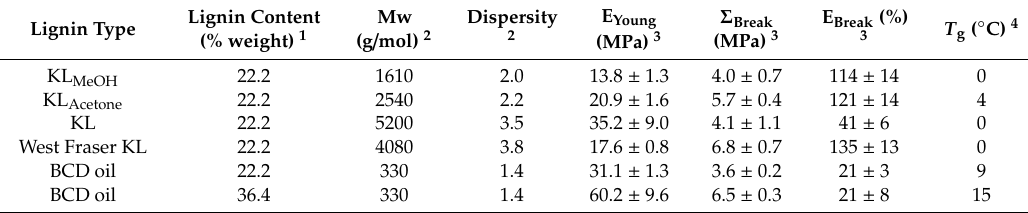
Table 5. E ff ect of the lignin type on the thermomechanical properties of the epoxy